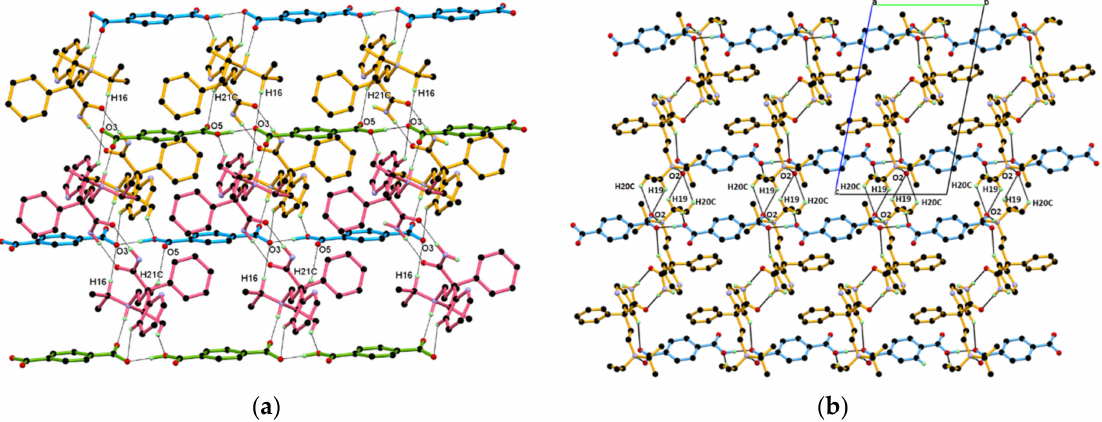
Figure 5. Packing of the 1D dimeric unit chain ( a ) along the a -axis through C16–H16 ··· O3 ¯ , C21–H21C ··· O5 interaction to generate a two-dimensional (2D) layer ( b ) along the ac -diagonal through C19–H19 ··· O2 ¯ and C20–H20C ··· O2 ¯ interaction to generate a 2D layer.